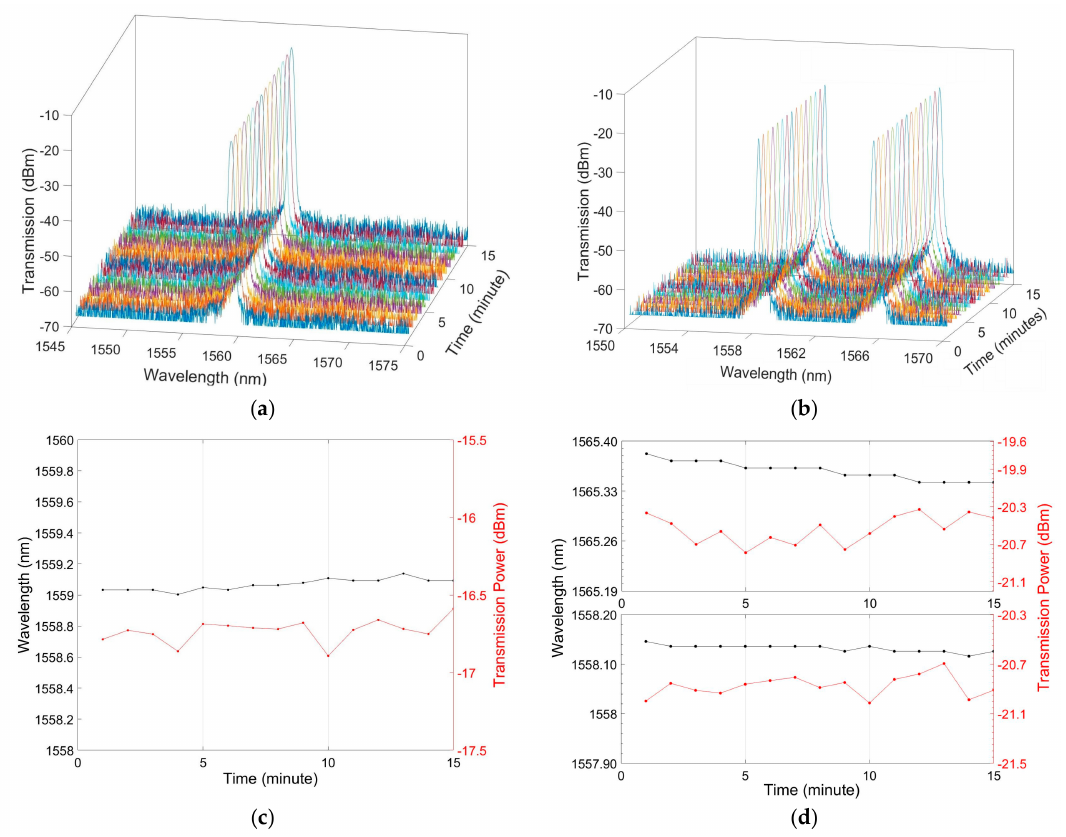
Figure 5. Characteristics of 15-times repeated scans of the oscillation operations for ( a ) a single wavelength at 1559.03 nm and ( b ) a dual wavelength at 1558.15 and 1565.38 nm; Wavelength and power fluctuation for ( c ) the single wavelength EDFL and ( d ) the dual wavelength